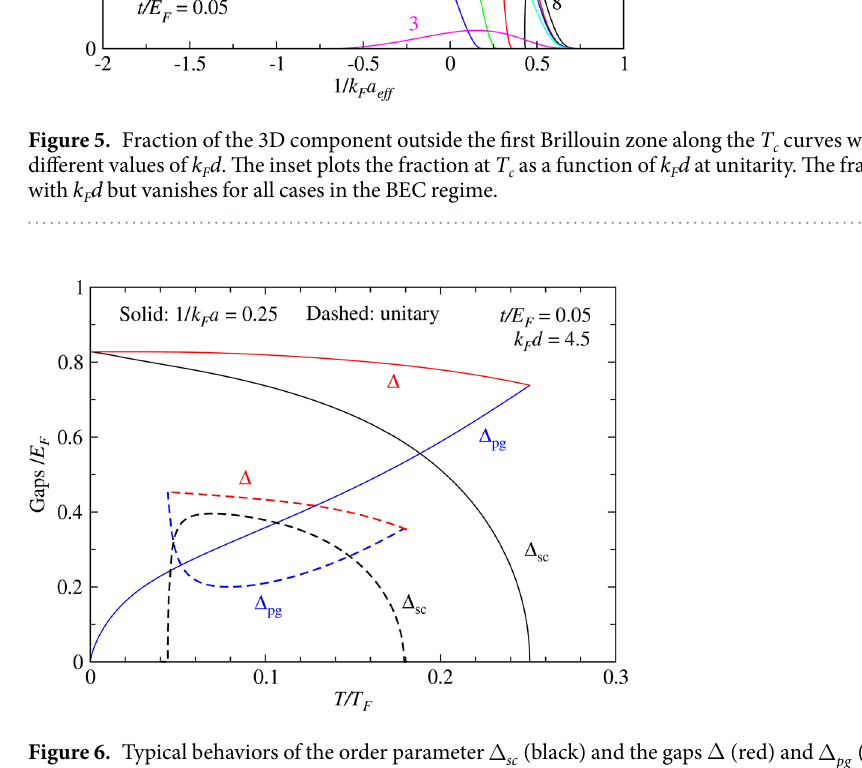
Figure 6. Typical behaviors of the order parameter Δ (black) and the gaps Δ (red) and Δ sc function of T T / for = . k a 1/ 0 25 (solid) and unitary (dashed lines), representing cases without and with F F intermediate temperature superfluidity, respectively. Here t / E F = 0.05 and k F d = 405, as